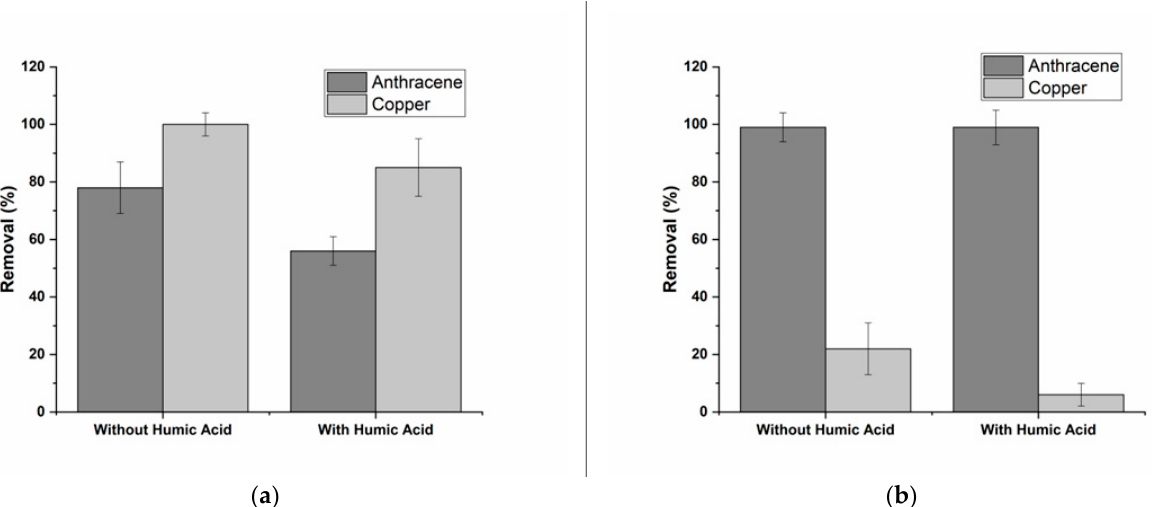
Figure 5. Simultaneous removal of anthracene and copper (II) ions in the absence and presence of humic acid by: ( a ) alginate spheres with activated carbon; and ( b ) polycaprolactone microparticles. The assays were carried out with aqueous solutions containing the two pollutants at initial concentrations of 1 mg/L anthracene and 4 mg/L copper ions. In the assays with humic acid, the concentration was 100 mg/L. An adsorbent dose of 6 mg/mL was applied, and the removal was measured at 24 h. The results are the mean ± SE from triplicate experiments.